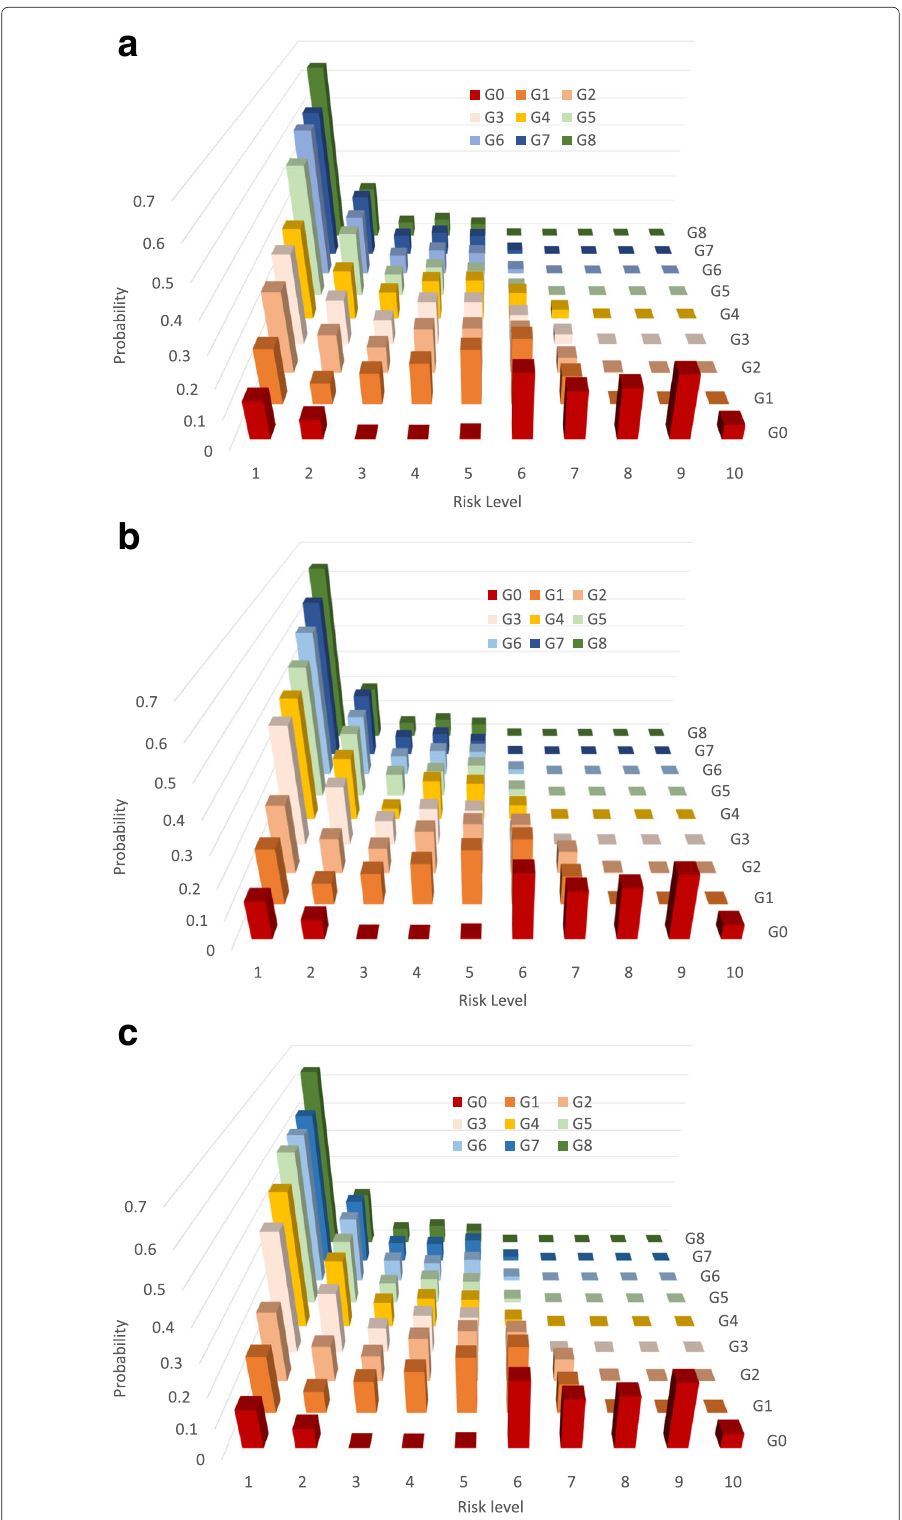
Fig. 6 Comprehensive risk mitigation progress. a mitigation effects of decision OptionA. b mitigation effects of decision OptionB. c mitigation effects of decision